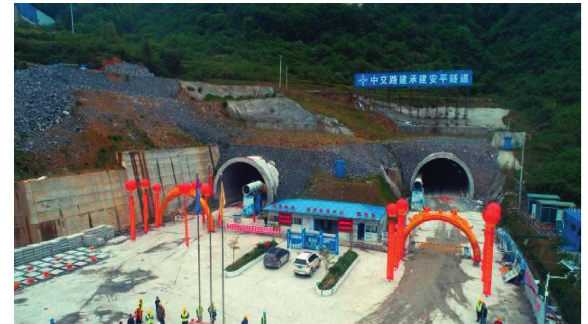
Figure 7: Working contest was held in Case 11 (source: http:// www.zgjtb.com/zhitong/2020-04/28/content_241692.htm).